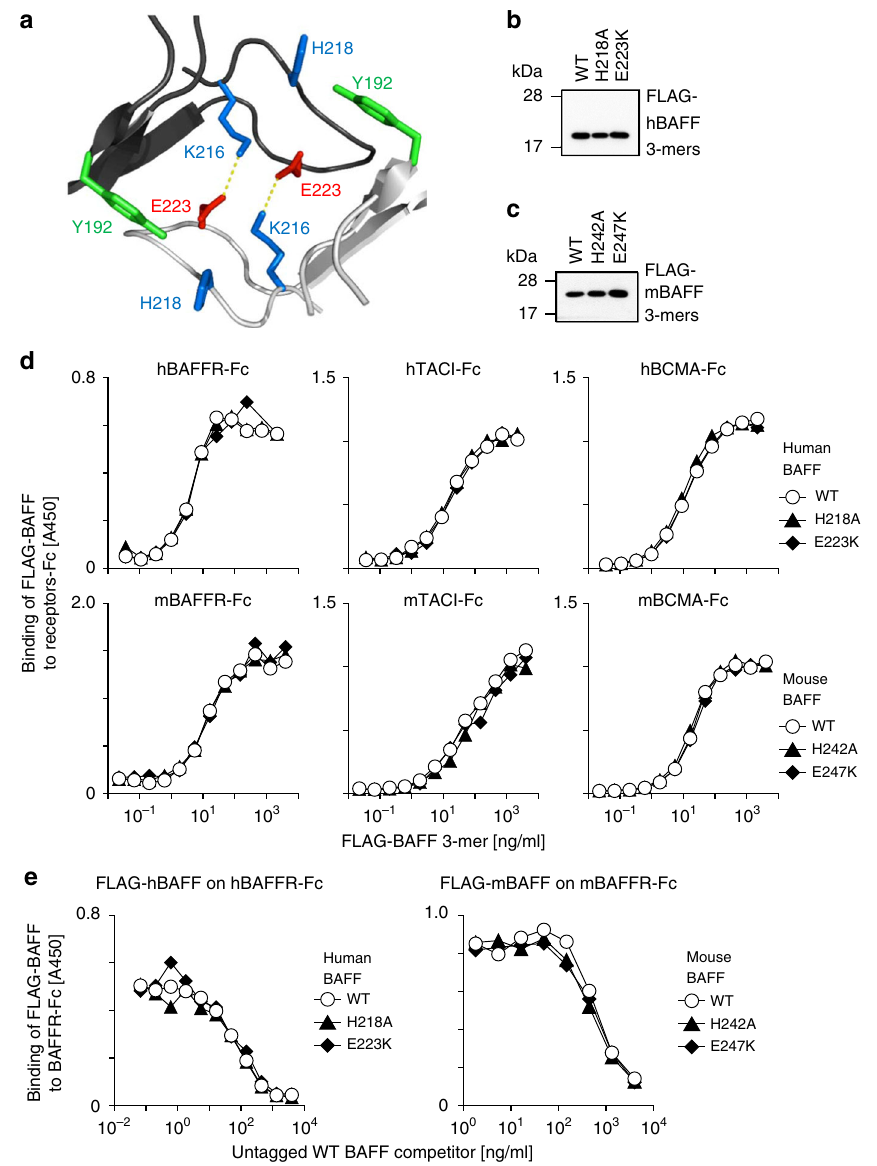
Fig. 1 Mutations in the fl ap do not affect binding of BAFF to its receptors. a Residues involved in fl ap – fl ap interactions between adjacent BAFF 3-mers. Parts of BAFF monomers in adjacent 3-mers are shown in black and white, respectively. Side chains of some residues known or predicted to be important for fl ap – fl ap interactions are depicted and numbered according to the human BAFF sequence. The illustration was drawn from coordinates PDB-ID 4V46 23 . b FLAG-tagged human BAFF 3-mers wild type (WT) or with mutations (H218A and E223K) in fl ap residues were produced by transient transfection of 293 T cells, recovered in supernatants, size fractionated by gel fi ltration and adjusted to comparable concentrations. 80 ng of each protein was analyzed by anti-FLAG western blotting. c Same as panel b , but for FLAG-tagged mouse BAFF with the corresponding fl ap mutations. d ELISA was used to monitor the binding of WT or mutant FLAG-tagged BAFF to recombinant BAFFR-Fc, TACI-Fc, or BCMA-Fc, with anti-FLAG detection. Binding of human BAFF was probed on human receptors (graphs on the top), and binding of mouse BAFF on mouse receptors (graphs at the bottom). The experiment was performed twice. e Titrated amounts of untagged WT BAFF were added to BAFFR-Fc coated in an ELISA plate, followed by a fi xed amount of FLAG-BAFF (WT or the indicated mutants) and detection of binding with an anti-FLAG antibody. Absence of signal reveals that untagged BAFF had bound to BAFFR-Fc. Left graph: human BAFF on hBAFFR-Fc. Right graph: mouse BAFF on mBAFFR-Fc. The experiment was performed once for human BAFF and twice for mouse BAFF. See also Supplementary Fig. one-way Anova) for slightly higher numbers of mature B cells in knock-in mice express and conventionally process BAFF E247K knock-in mice compared to knock-out, which might re fl ect a that is then able to bind receptors. Despite the presence of cir- residual activity of either soluble or membrane-bound BAFF culating BAFF, the B cell phenotype of knock-in mice resembled E247K (Fig. 3c – f). These results indicate that BAFF E247K can- that of BAFF knock-out with reduced numbers of CD19 + CD93 − not, or only very poorly, activate BAFFR in vivo. mature B cells in the spleen, decreased B/T ratio in lymph nodes, In the absence of B cells, circulating levels of BAFF usually but normal numbers of (BAFF-independent) immature CD19 + CD93 + splenic B cells (Fig. 3c – f, Supplementary Fig. 3, Supple- rise 20,26 . We wondered why BAFF levels in B lymphopenic mentary Table 1). There was a non-signi fi cant trend ( p > 0.05 by knock-in mice were not higher than in WT and we found that the